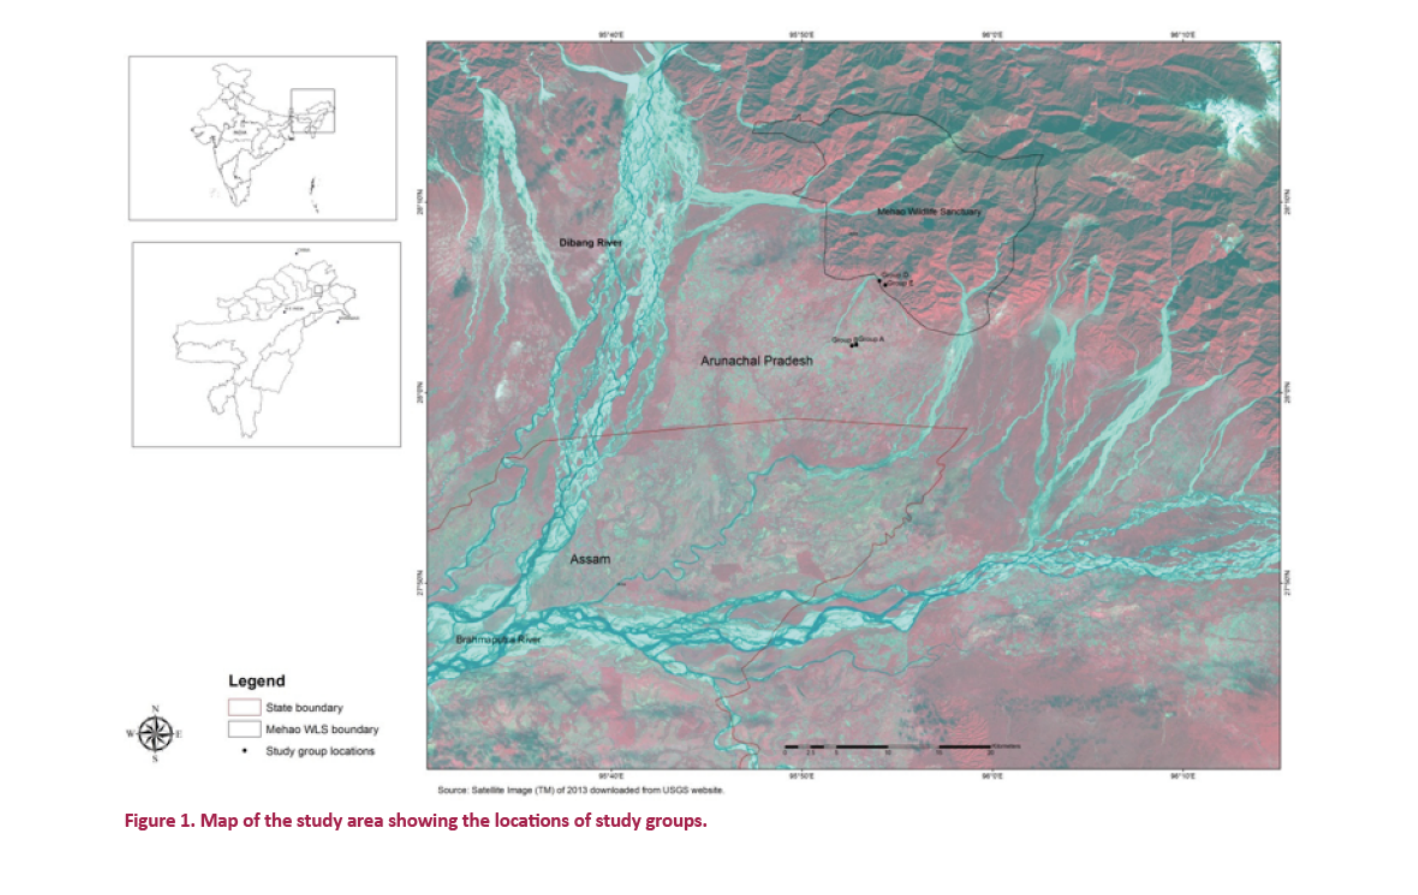
Fffigure 1. Map off tthe sttudy area showffing tthe locaffions off sttudy